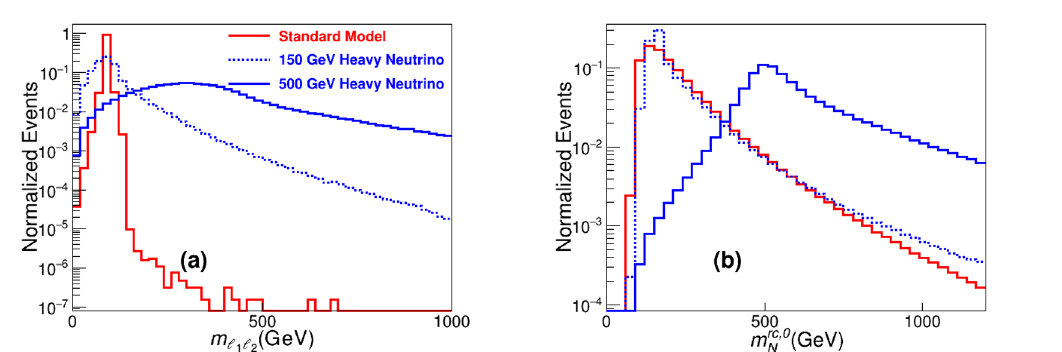
(left) and m rc , 0 (right) of SM backgrounds (red) and heavy N 1 ‘ 2 = 150 GeV (dashed blue) and 500 GeV (solid blue) at N